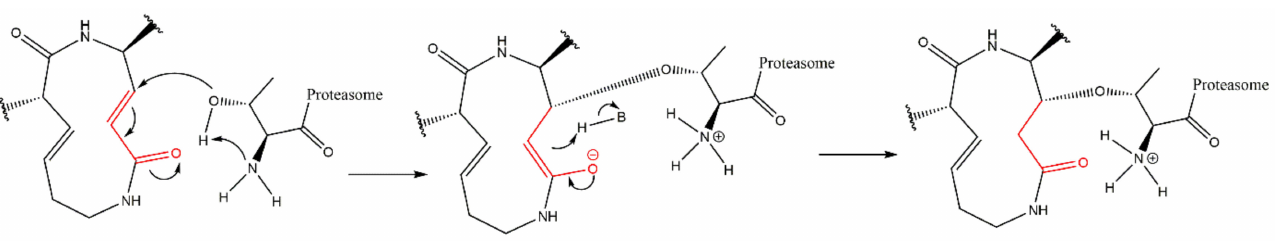
Figure 19. Mechanism of proteasome inhibition by syrbactin inhibitor, via a Michael-type 1,4- addition